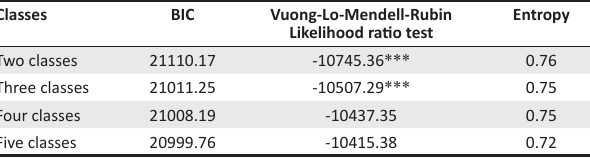
TABLE 2: Fit indices and entropy for different class solutions.